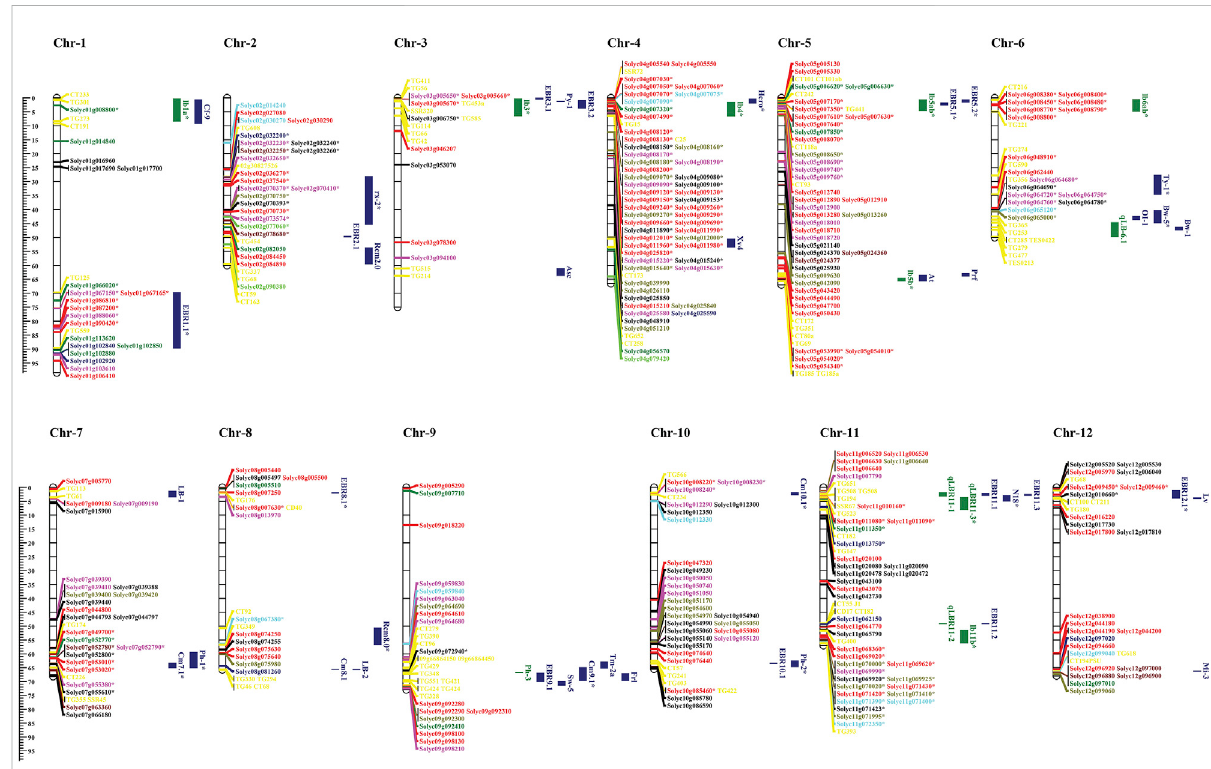
FIGURE 8 Co-localizationofthenumberof NLR genesdistributedon12chromosomesoftomatomappedwithQTLs.Blue:blightresistance(EBR);green: late blight resistance (LBR). The physical positions are shown in Mbp. Gene colors indicate f NLR gene subfamilies in tomato. Red: CNL; dark green: TNL subfamily; dark blue: TN; bright red: NL; bright green: RNL; dark red: TIR; sky blue: LRR; mustard: CN; black: N sub-family. The markers present within QTL intervals are shown in yellow on the chromosomes. Genes within the QTLs are marked with